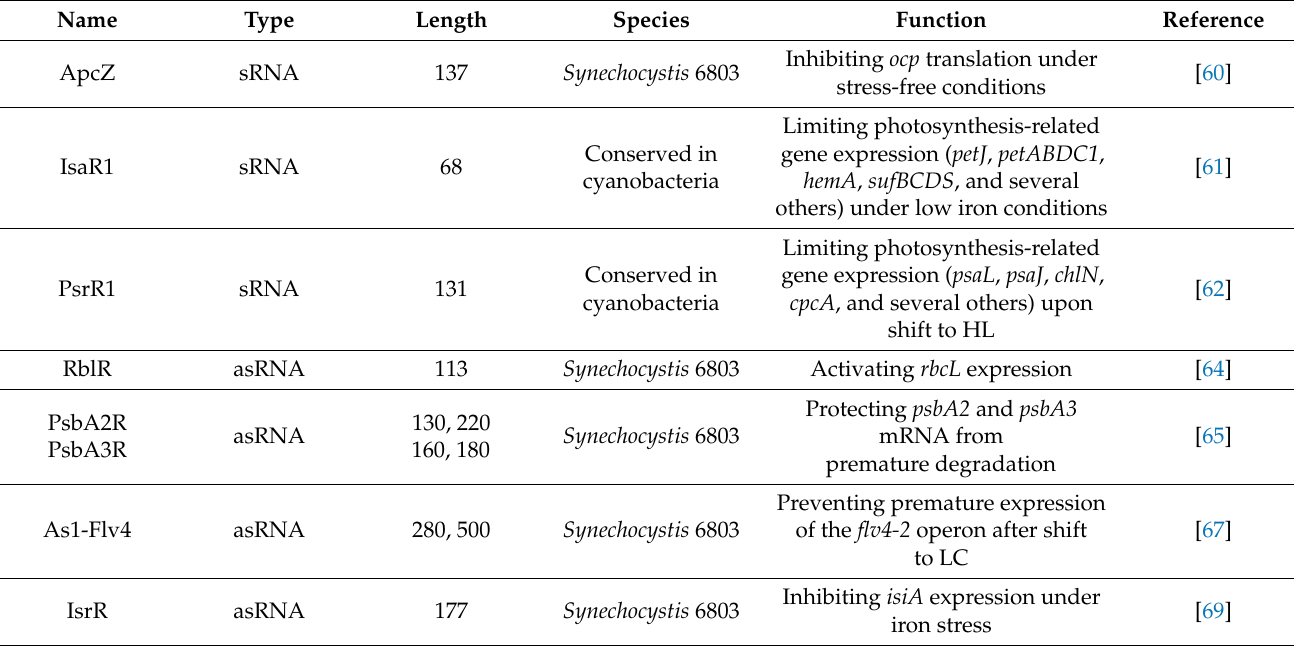
Table 1. ncRNAs relating to photosynthesis in